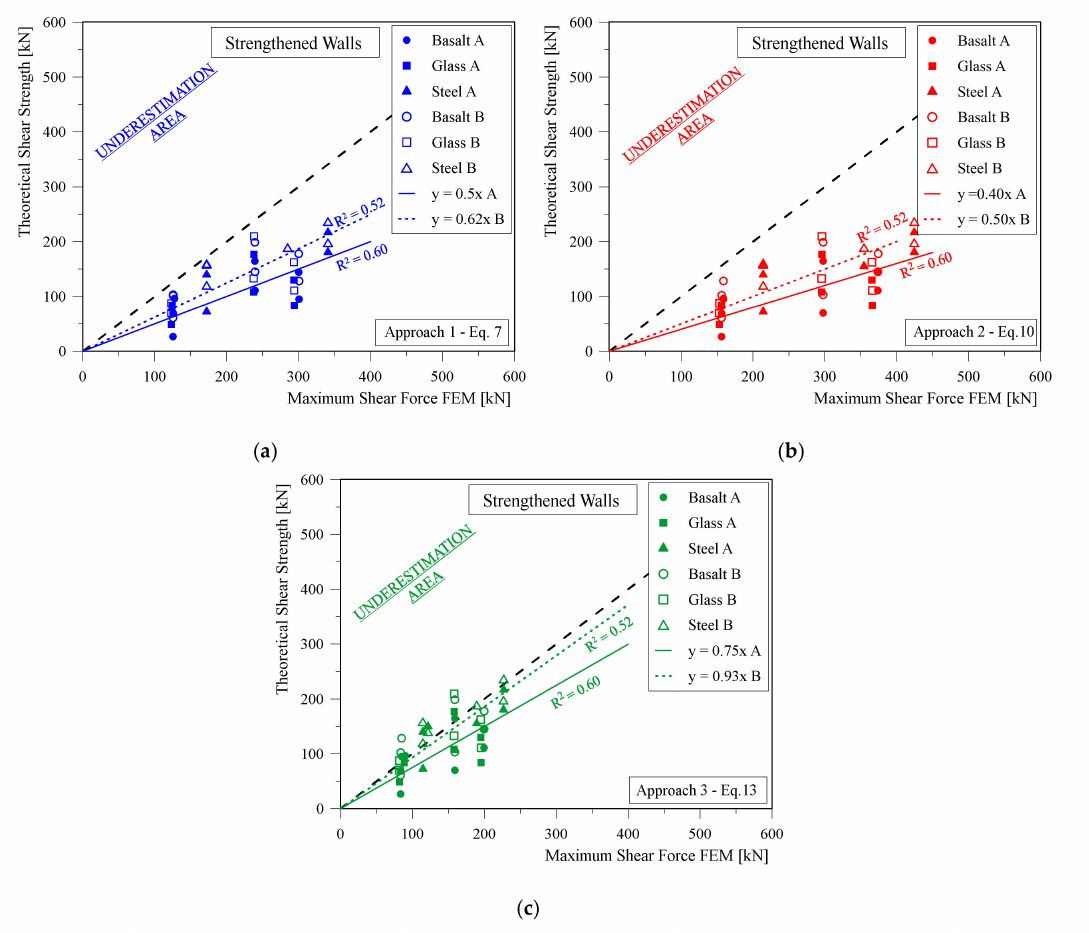
Figure 6. Comparison between theoretical shear strength and FEM predictions for strengthened walls: ( a ) Approach 1; ( b ) Approach 2; ( c ) Approach